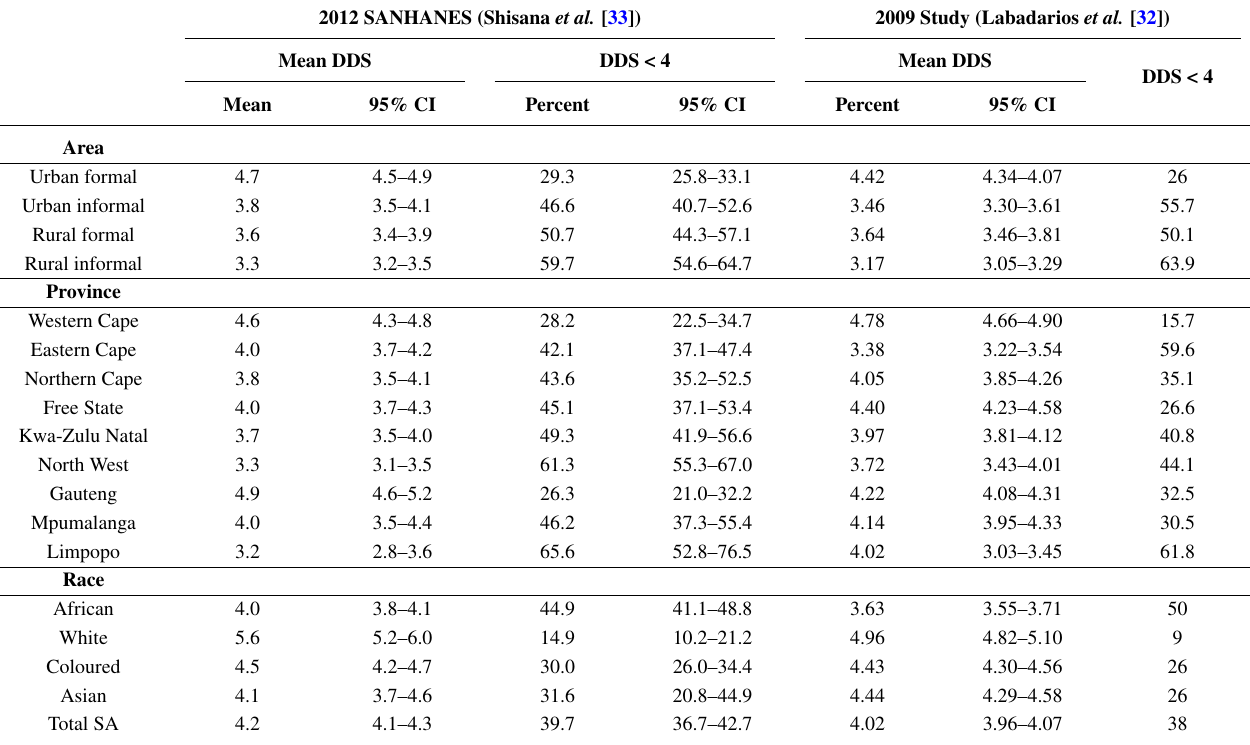
Table 6. Mean dietary diversity scores (DDSs) based on items from nine food groups, according to two South African national